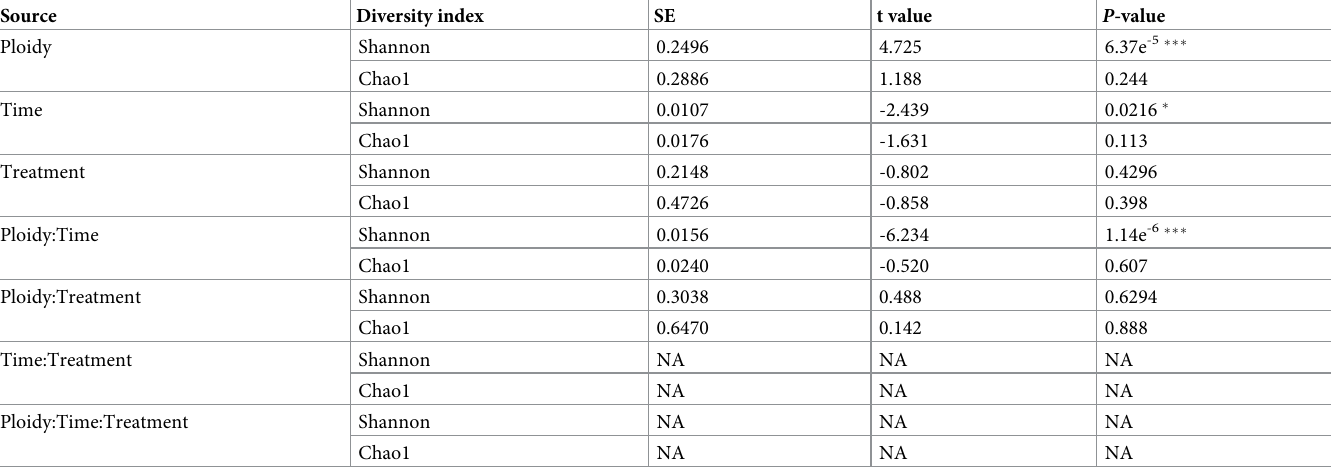
Table 2. Mixed model ANOVA analysis of Shannon Diversity Index, and Chao1 in gills of diploid and triploid salmon.